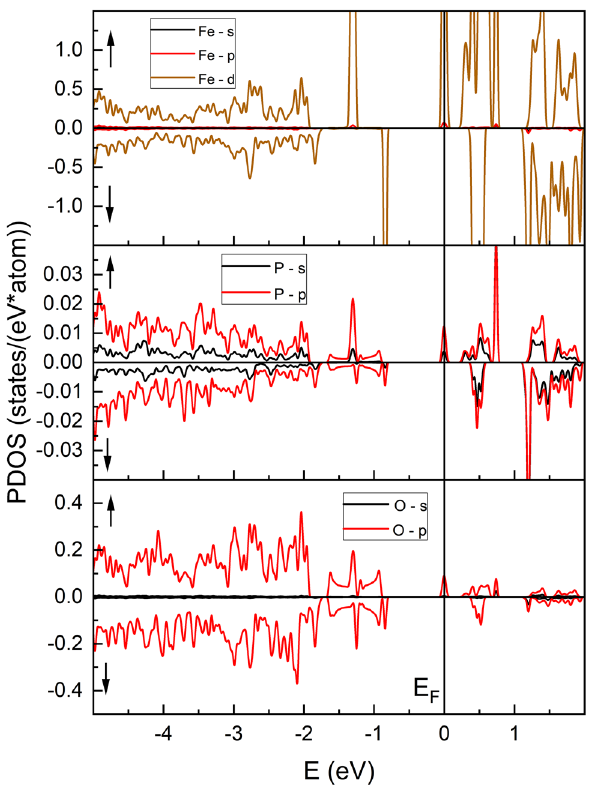
Figure 6. Partial densities of states (PDOS) for Fe 7 P 11 O 38